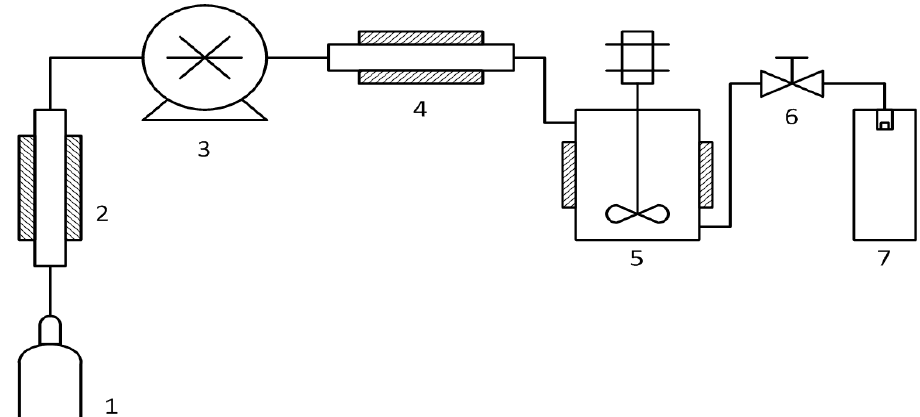
Figure 1. Schematic representation of the rapid expansion of supercritical suspensions (RESS) experimental setup. 1 is a СО 2 cylinder; 2 is a cooler; 3 is a СО 2 pump; 4 is a heater; 5 is a high pressure vessel with a magnetically driven 4-blade stirrer; 6 is a valve; 7 is a precipitation chamber with a heated spraying nozzle.